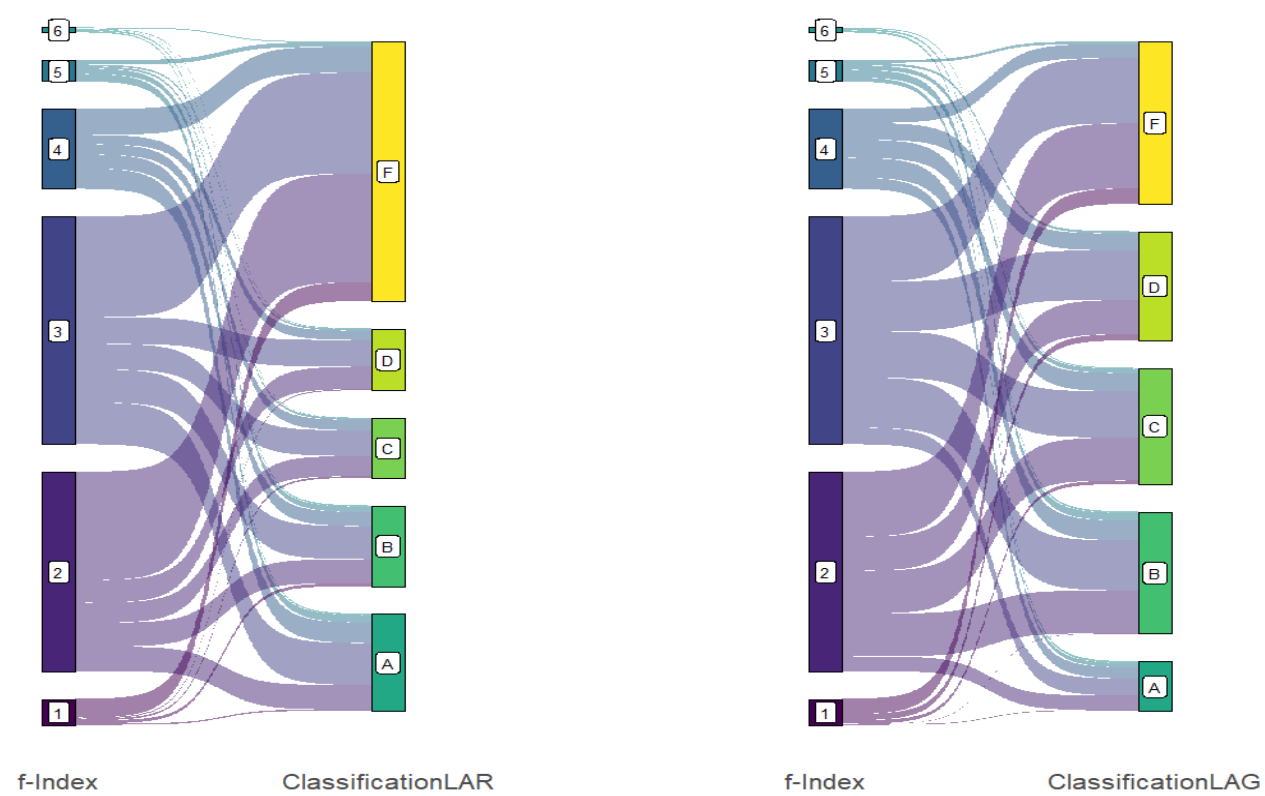
Figure 7. Diagram of flows between f -index and last average admission grade classification and last admission rank.